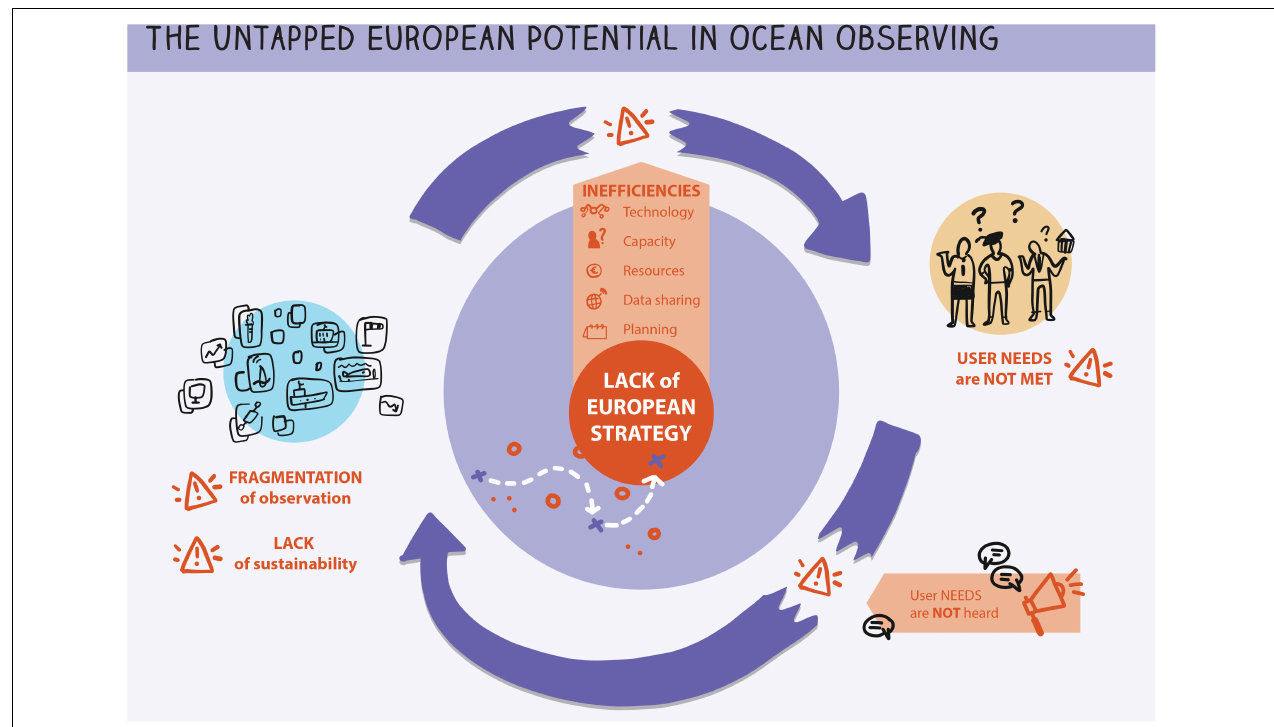
FIGURE 2 | The existing challenges and untapped potential of fragmented dispersed ocean observing